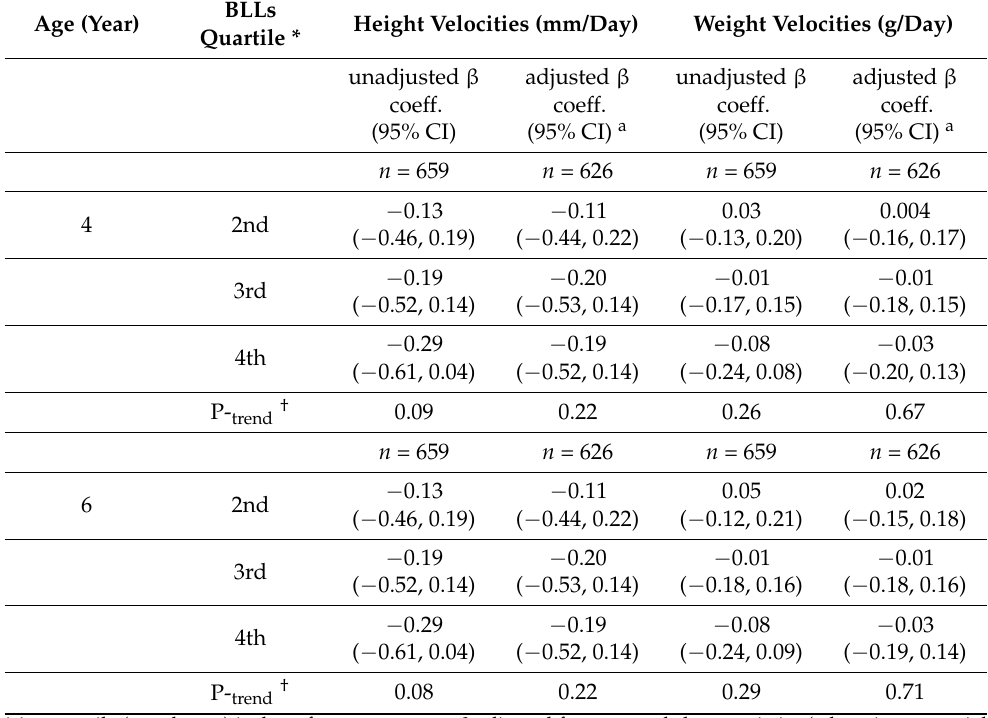
Table 3. Regression coefficients (95% confidence intervals) for the associations between blood lead levels at age 1 year and growth velocities at age 4 and 6 years in Beninese children (Allada